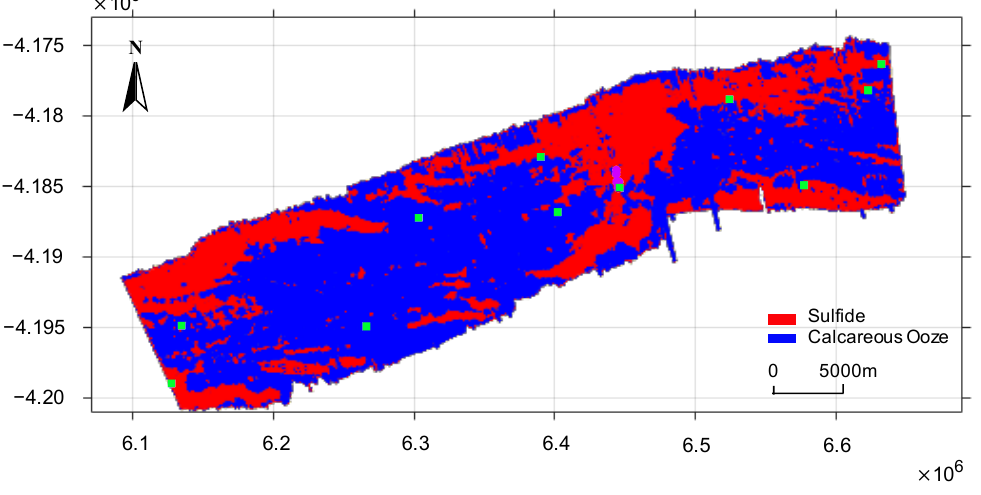
Figure 8. Seabed sediment classification results using unsupervised Fuzzy ISODATA.